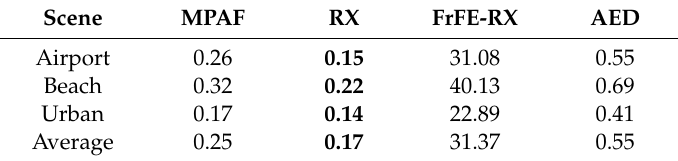
Table 4. The average computing time (in seconds) of the compared methods on the ABU